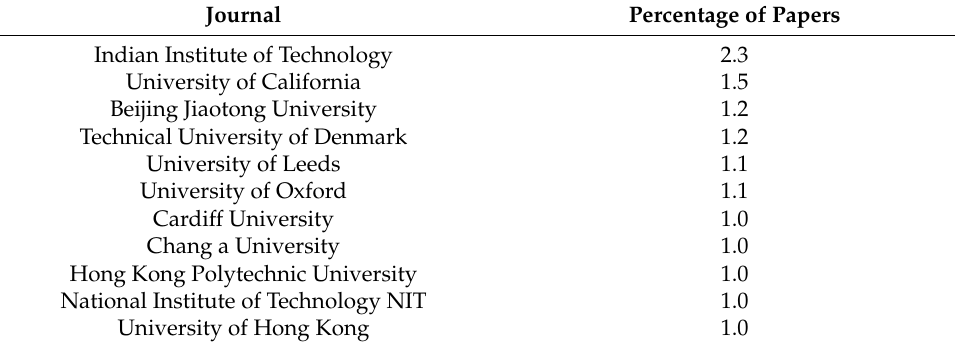
Table 6. Number of publications by the research